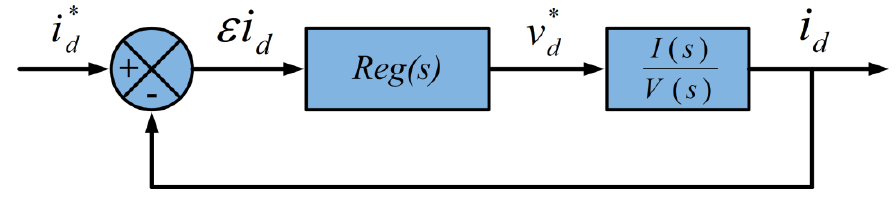
Figure 8. Closed loop current control.